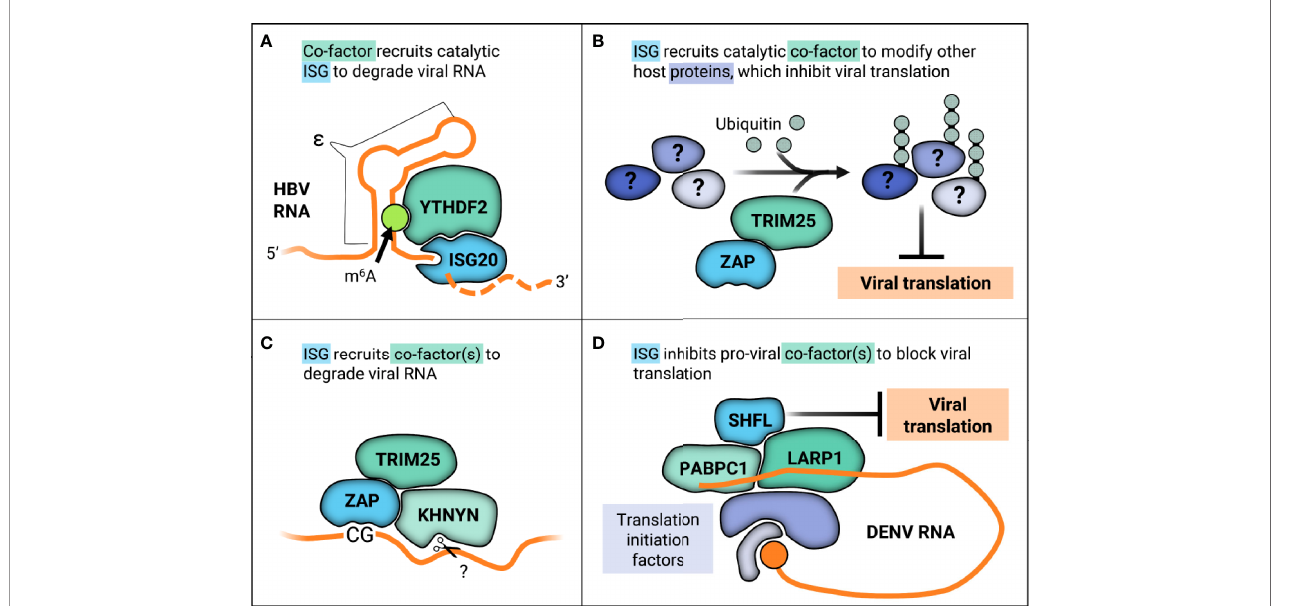
FIGURE 4 | ISGs work with co-factors in varied ways to inhibit viral replication through diverse mechanisms. (A) YTHDF2 recognizes m 6 A methylation on the ϵ in HBV RNA transcripts, recruiting catalytic ISG20 to degrade HBV RNA. (B) ZAP recruits TRIM25 to ubiquitinate other host proteins, which may alter their native cellular or viral-associated activities in order to inhibit viral translation. (C) ZAP recognizes CG motifs in viral RNA and forms a complex with TRIM25 and the endonuclease KHNYN, which then putatively cleaves ZAP-bound RNA. (D) SHFL inhibits DENV replication by interacting with the viral RNA 3 ’ UTR binding proteins PABPC1 and LARP1 and potentially inhibiting recruitment of further translation